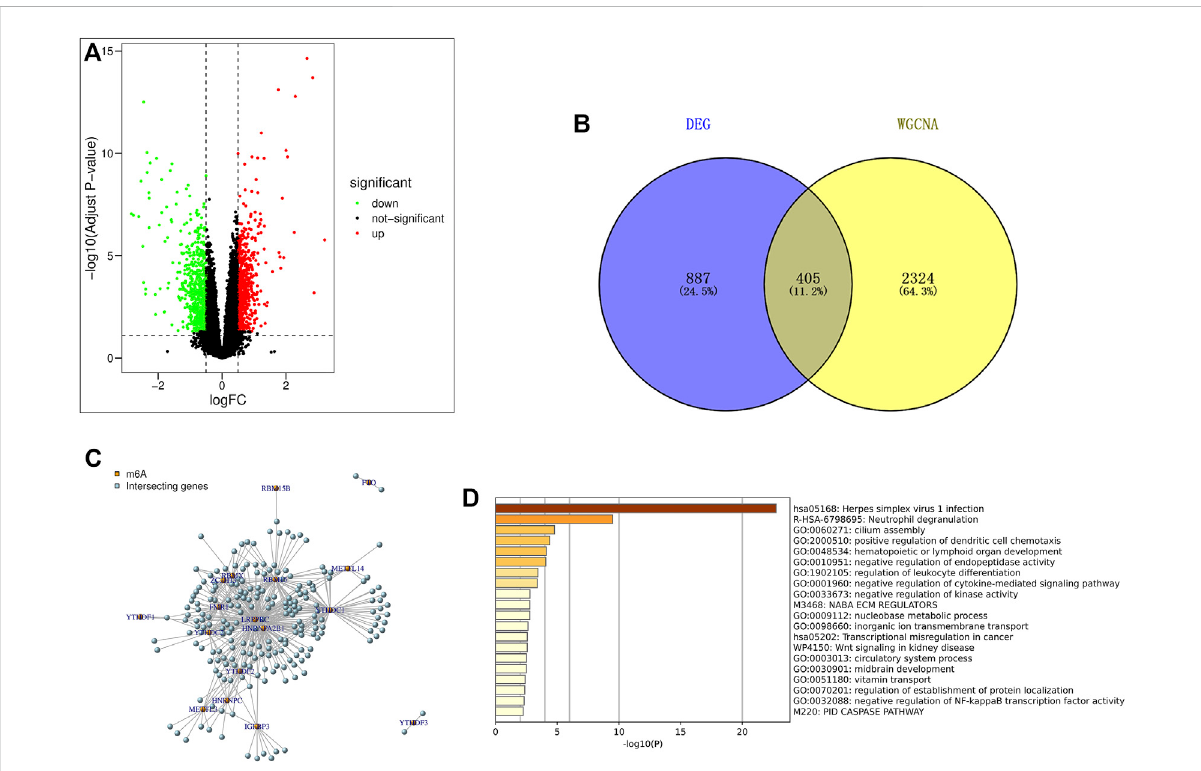
FIGURE 3 Screening and enrichment analysis of m6A related candidate genes. (A) Volcano map of differentially expressed genes (red are up-regulated genes, green are down-regulated genes, black are non-differentially expressed genes); (B) The genes screened by DEG and WGCNA were intersected by Venn diagram, and IPF highly correlated differentially expressed genes were obtained; (C) Pearson correlation analysis was used to screen out m6A-related candidate genes in IPF; (D) GO and KEGG enrichment analysis were performed for m6A related candidate